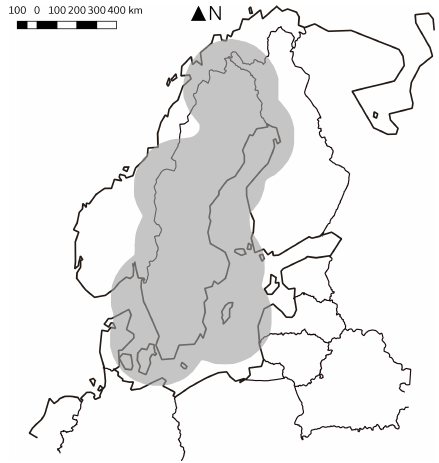
Figure 1. Domain of the used SMHI radar data covering most parts of